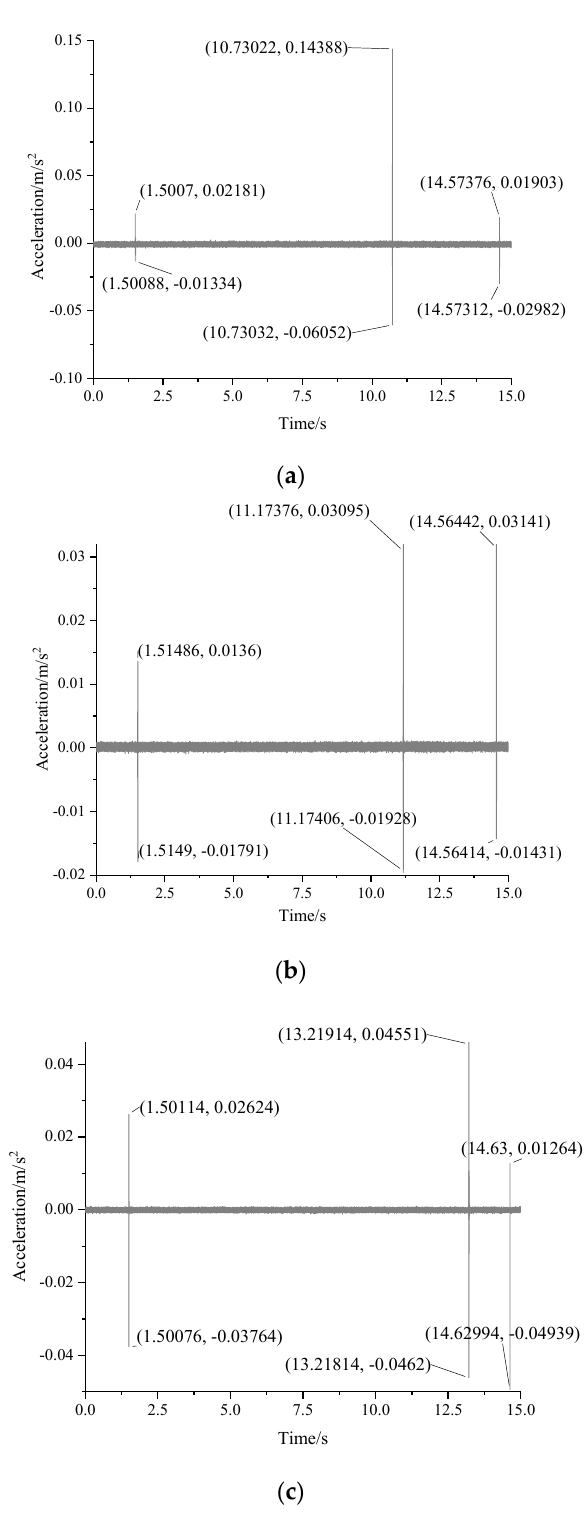
Figure 4. ( a ) Vibration signal in the opening process of the disconnector under the nominal condition. ( b ) Vibration signal in the opening process of the disconnector under the screw − loosened condition. ( c ) Vibration signal in the opening process of the disconnector under the transmission mechanism − jammed condition.